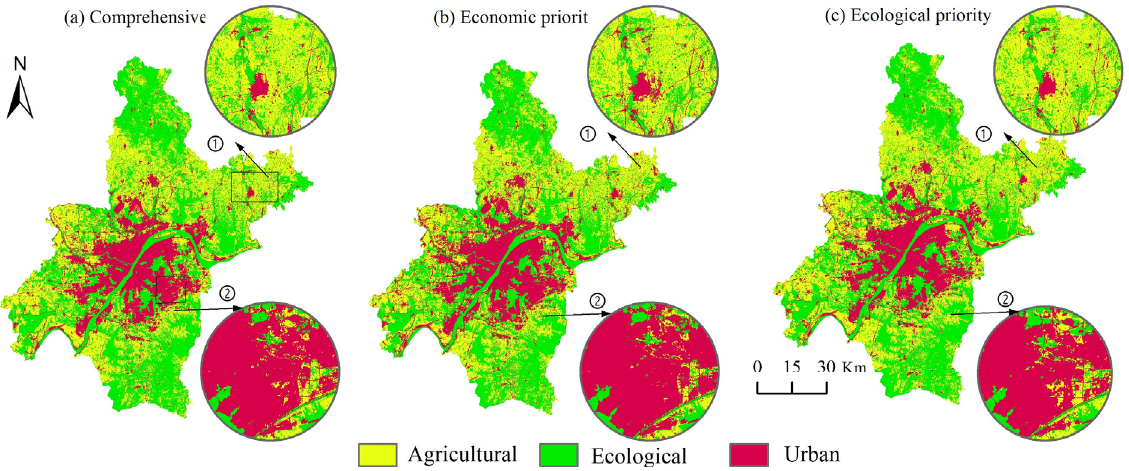
Figure 2. Three kinds of spatial layout optimization results. Table 4. Area statistics before and after “three categories” space optimization.